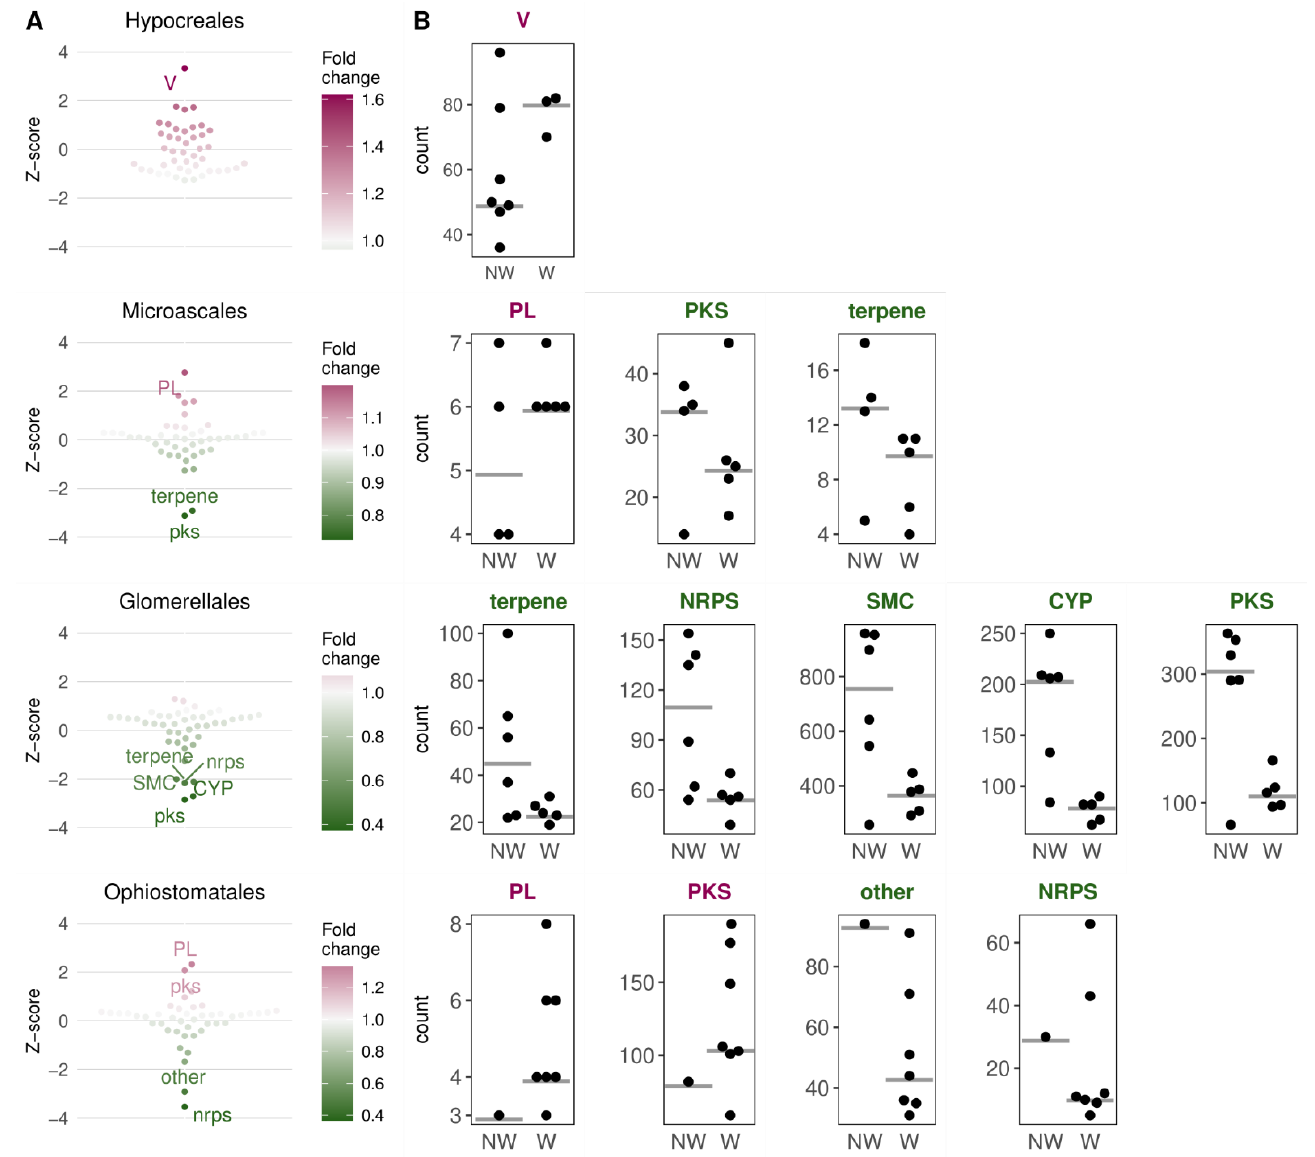
Figure 3. The most and least abundant gene classes in wilt relative to non-wilt-causing pathogenic species in four taxonomic groups of Sordariomycetes. ( A ) Normalized fold changes (z-scores) or ratios of median gene abundances in wilt vs. non-wilt-causing pathogens in four orders. The color indicates the strength of the fold change in wilt-causing relative to non-wilt-causing species. ( B ) Distribution of gene counts in gene classes whose medians (grey lines) were most differentiated between wilt- and non-wilt-causing fungi. Dots indicate gene counts of analyzed pathogenic